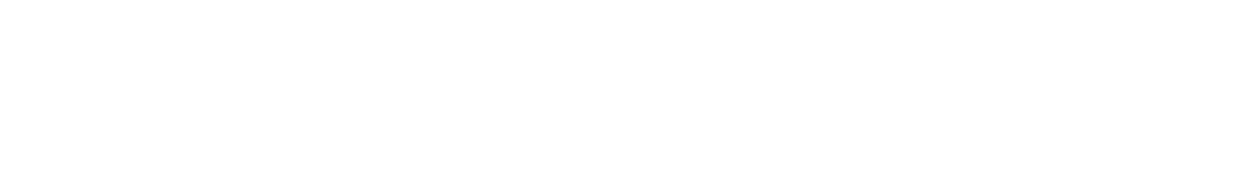
Frontiers in Environmental Science | www.frontiersin.org October 2021 | Volume 9 | Article 757976